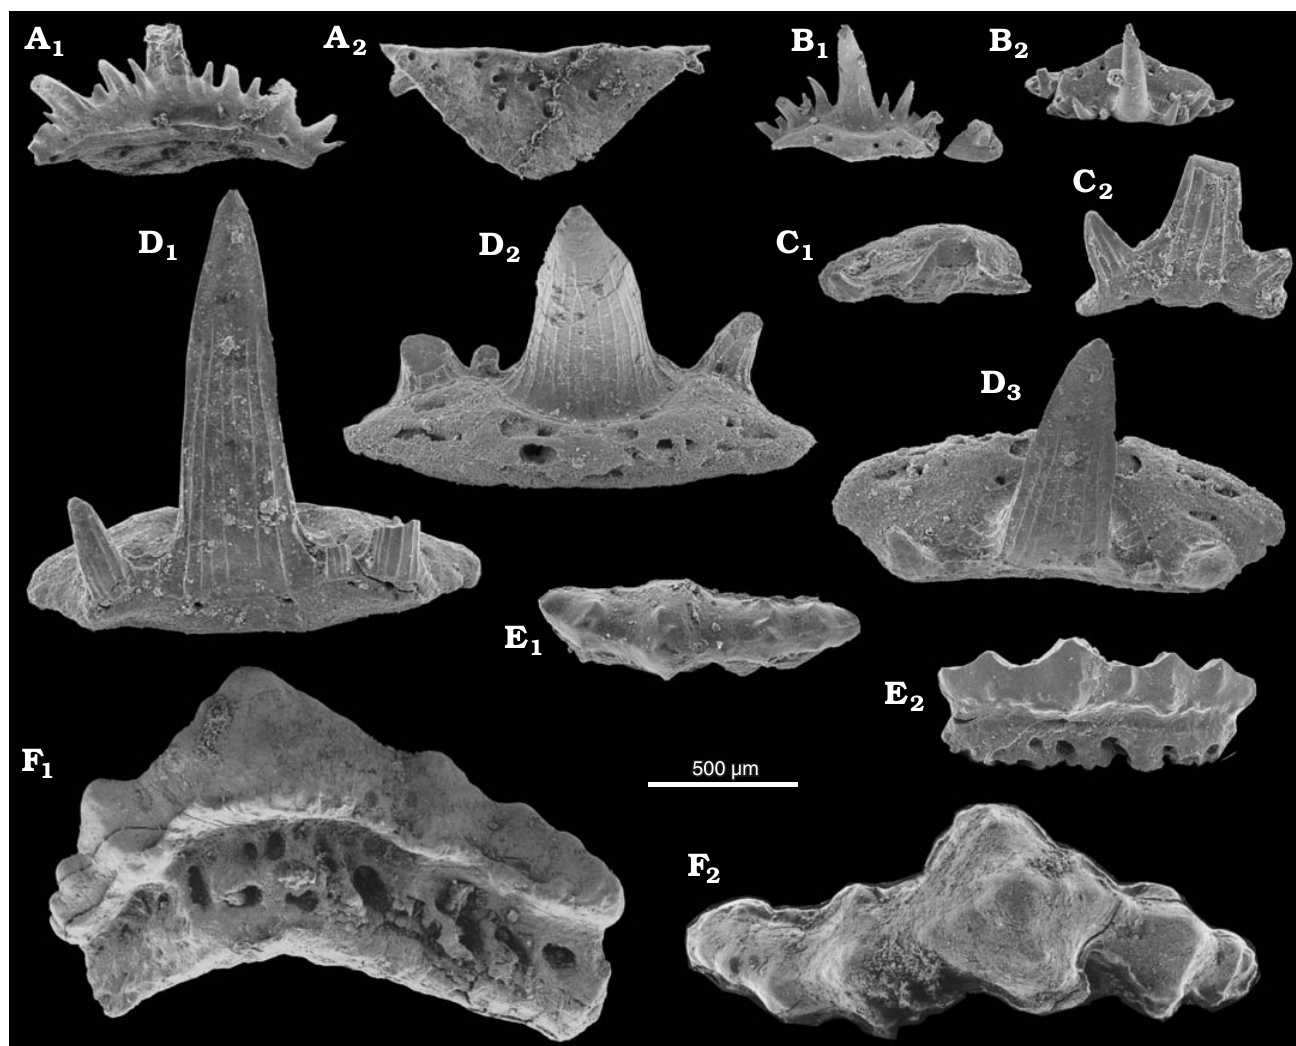
Fig. 5. Chondrichthyan fish teeth from the upper Viséan of Czerna, Poland. A , B . Cladodontomorphi indet. 1. A . ZPAL P. IV/255 in labial (A 1 ) and basal (A 2 ) views. B . ZPAL P. IV/306, small specimen with a broken piece lying nearby in lingual (B 1 ) and oral (B 2 ) views. C . Ctenacanthidae indet., ZPAL P. IV/307 in oral (C 1 ) and labial (C 2 ) views. D . Cladodontomorphi indet. 2, ZPAL P. IV/308 in labial (D 1 ), lingual (D 2 ), and oral (D 3 ) views. E . Cassisodus sp., ZPAL P. IV/309 in oral (D 1 ) and lingual (D 2 ) views. F . Cassisodus sp., ZPAL P. IV/232 in lingual (E 1 ) and oral (E 2 )